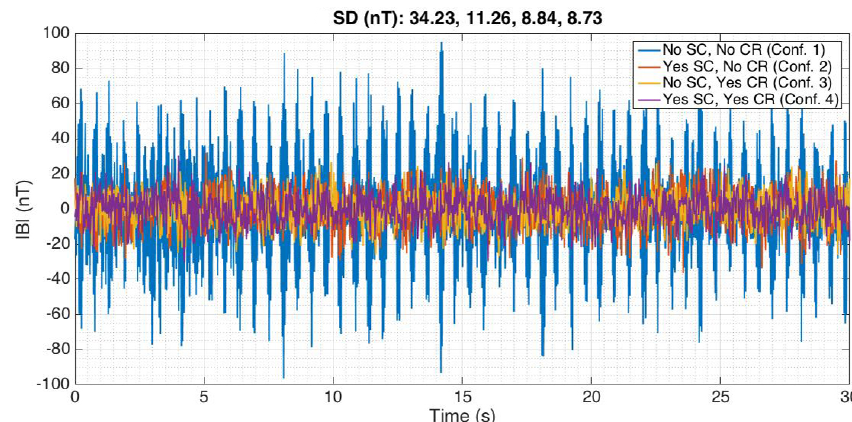
Figure 5. Zero applied field measurements under different shield can–copper room configurations.